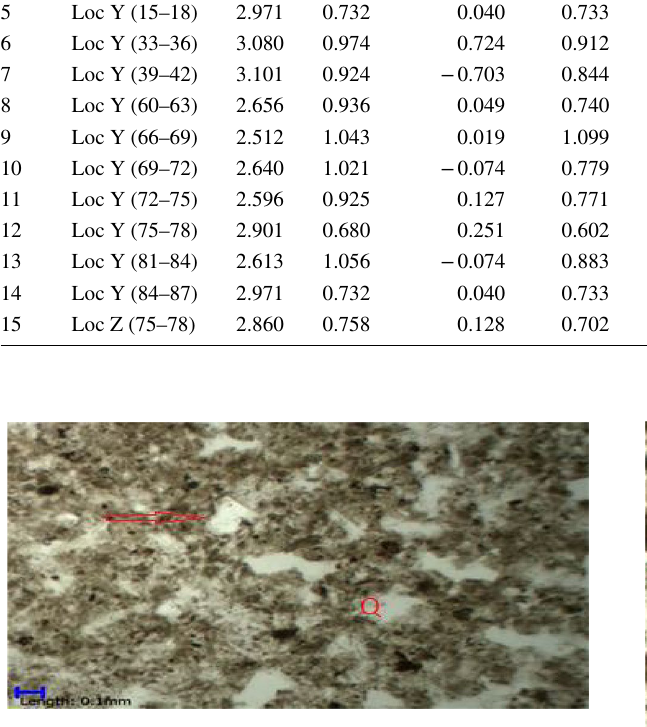
Fig. 6 Grain shape and size as observed from the petrographic micro- scope from Well X at a depth of 54–57 m